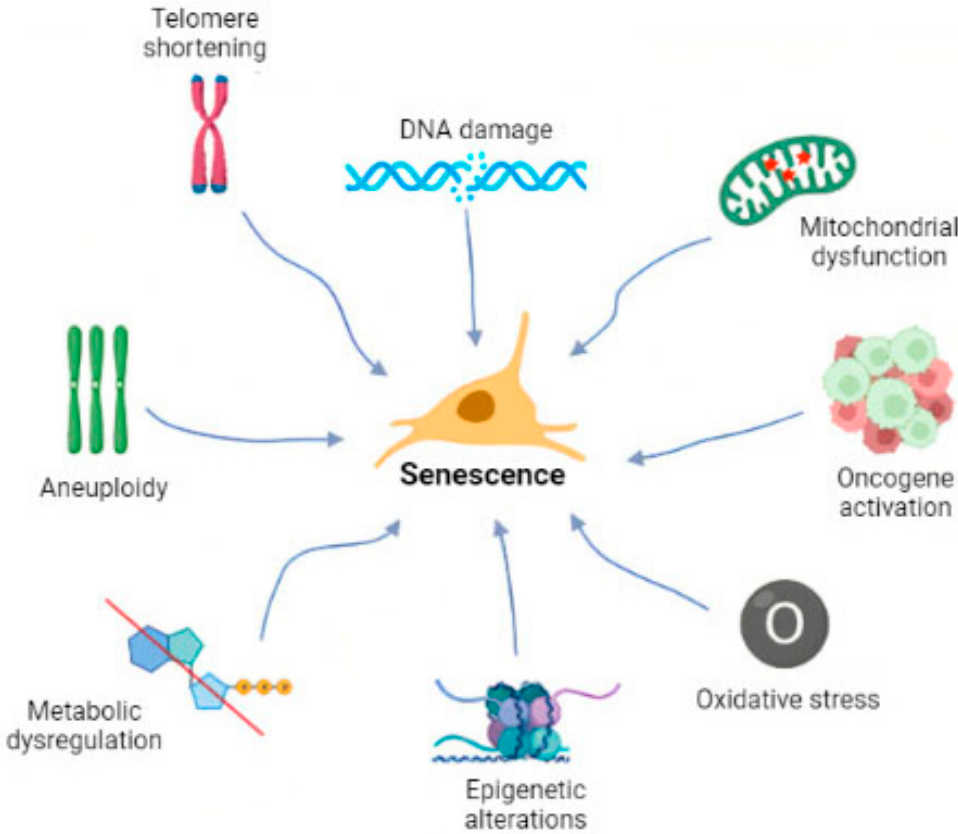
Figure 1. Cellular senescence can be induced by several stimuli. The first to be identified was telomere shortening, which is closely connected to so-called replicative senescence. Genomic changes, including DNA damage, oncogene activation, aneuploidy, and epigenetic changes, can also lead to senescence. Other factors that may contribute to irreversible cell cycle arrest include mitochondrial dysfunction, large-scale ROS generation, and metabolic